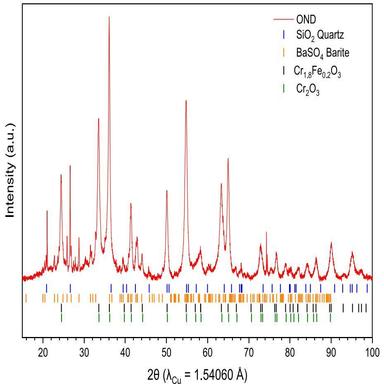
PXRD pattern of ODND, performed with a Cu source (λCu = 1.5406 Å). Five possible phases were indexed, and shown as colored stick: quartz SiO2 (PDF 46- 1045) in blue, barite BaSO4 (PDF 83-2053) in orange, Cr1.8Fe0.2O3 (PDF 04-006-8202) in black and chromium oxide Cr2O3 (PDF 85-0730) in green. (For interpretation of the references to colour in this figure legend, the reader is referred to the web version of this article.)